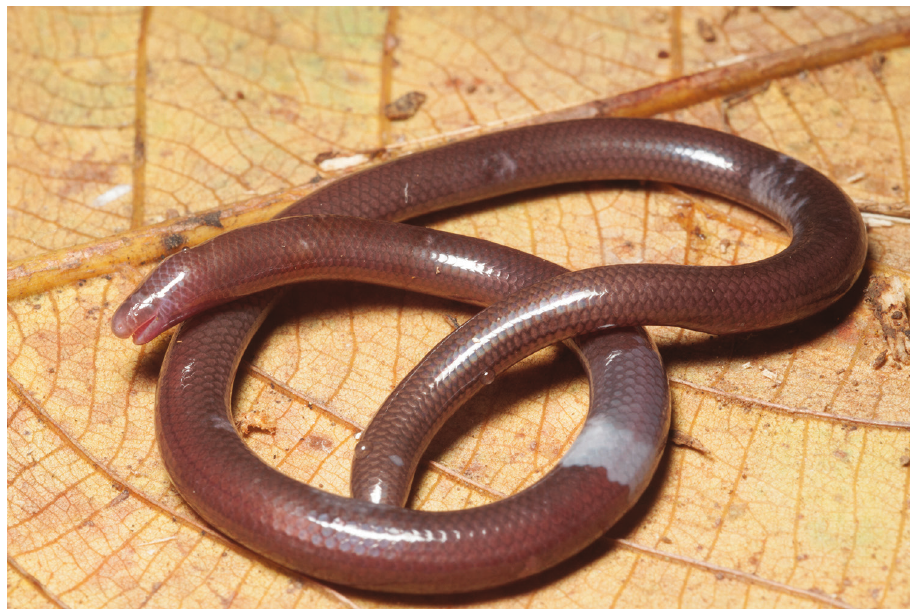
Figure 45. Dibamus cf. leucurus male (KU 334071) from Mt. Lumot, Municipality of Gingoog, Misamis Oriental Province. Photo: